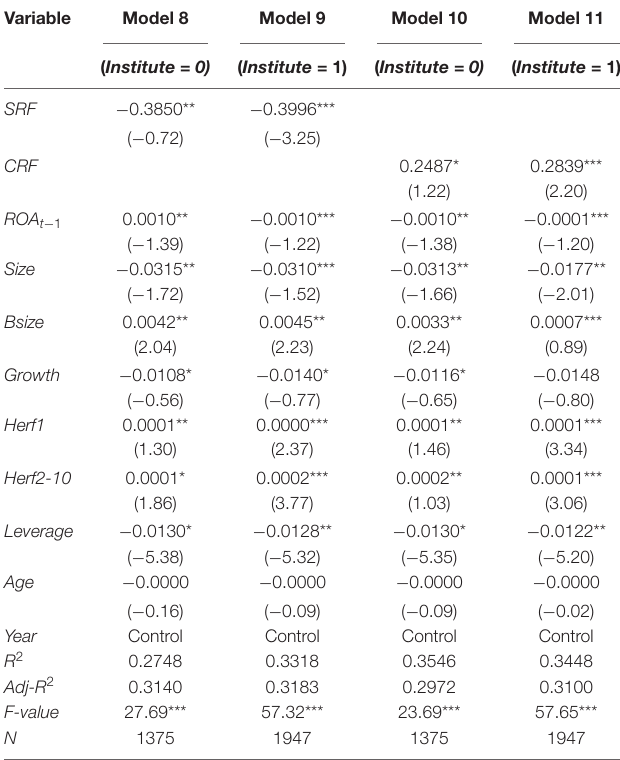
TABLE 5 | Impact of institutional environment on the relationship between board faultlines and innovation strategy